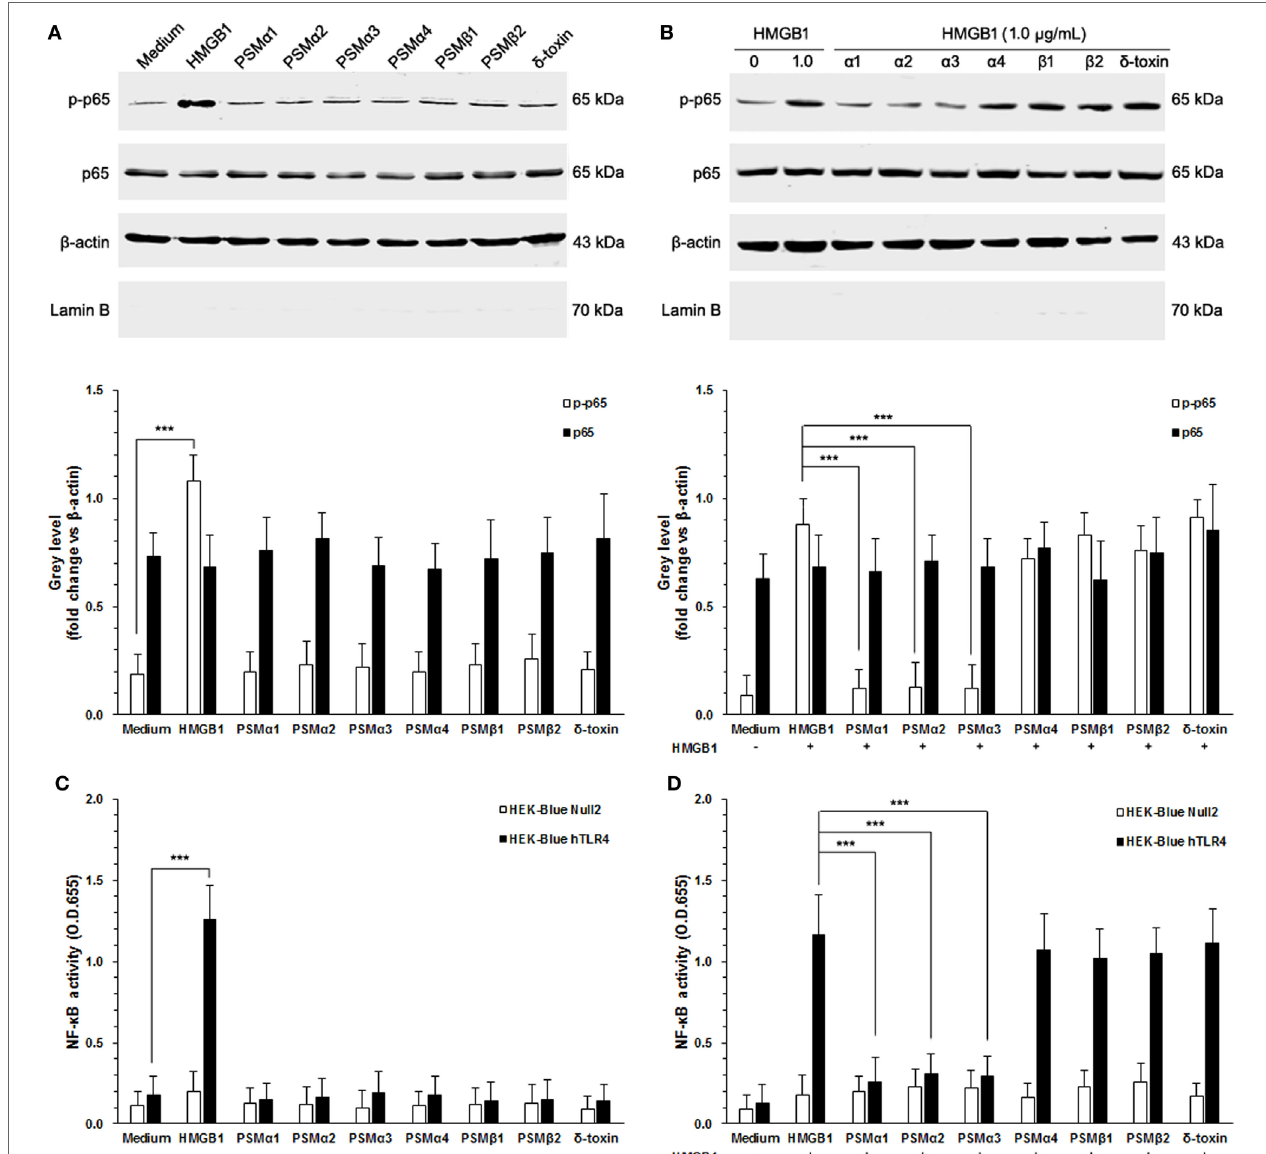
FigUre 3 | Staphylococcus aureus phenol-soluble modulins (PSMs) α 1– α 3 inhibit HMGB1-induced NF- κ B activation. (a) HEK-Blue hTLR4 cells were stimulated for 30 min with 1.0 µg/mL recombinant HMGB1 or S. aureus PSMs (PSM α 1, 5 µg/mL; PSM α 2, 5 µg/mL; PSM α 3, 0.5 µg/mL, PSM α 4, 5 µg/mL; PSM β 1, 10 µg/mL; PSM β 2, 10 µg/mL; δ -toxin, 2 µg/mL). NF- κ B p65 protein and phosphorated p65 at Ser536 in the cytoplasm were assessed by immunoblotting. β -actin and LaminB were used as control. LaminB in the cytoplasm was detected to ensure that there was no contamination during the fractionation. (B) Phosphorylation of NF- κ B in HEK-Blue hTLR4 cells challenged with HMGB1 in the presence and absence of S. aureus PSMs as prior described. (c) HEK-Blue hTLR4 cells and HEK-Blue Null2 cells (as control) were stimulated for 30 min with 1.0 µg/mL recombinant HMGB1 or S. aureus PSMs as prior described. NF- κ B-induced secreted embryonic alkaline phosphatase (SEAP) activity was assessed using QUANTI-Blue and by reading the OD at 655 nm. (D) The NF- κ B-induced SEAP activity of HEK-Blue hTLR4 cells or HEK-Blue Null2 cells (as control) challenged with HMGB1 in the presence and absence of S. aureus PSMs as prior